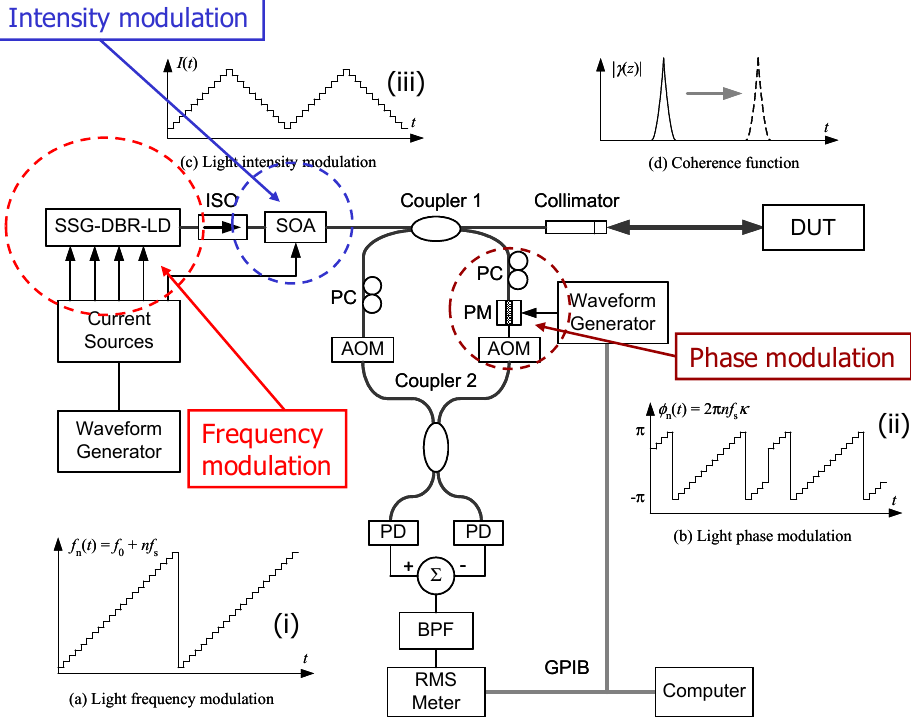
Figure 6. SOCF setup to synthesize arbitrary-shaped optical coherence functions [22]. Waveform for FM, PM, and IM are shown in Figure 6i, 6ii, and 6iii, respectively.